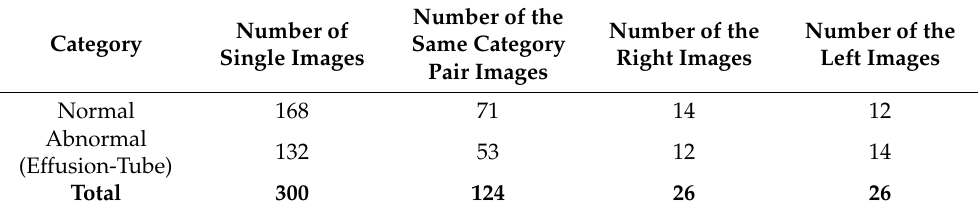
Table 1. The number of images for each class of eardrum types. Both right and left eardrum images have the same diagnosis, and right and left different category image numbers in the dataset. Number of the Number of Number of the Number of the Category Same Category Single Images Right Images Left Images Pair Images Normal 168 71 14 12 Abnormal 132 53 12 14 (Effusion-Tube) Total 300 124 26